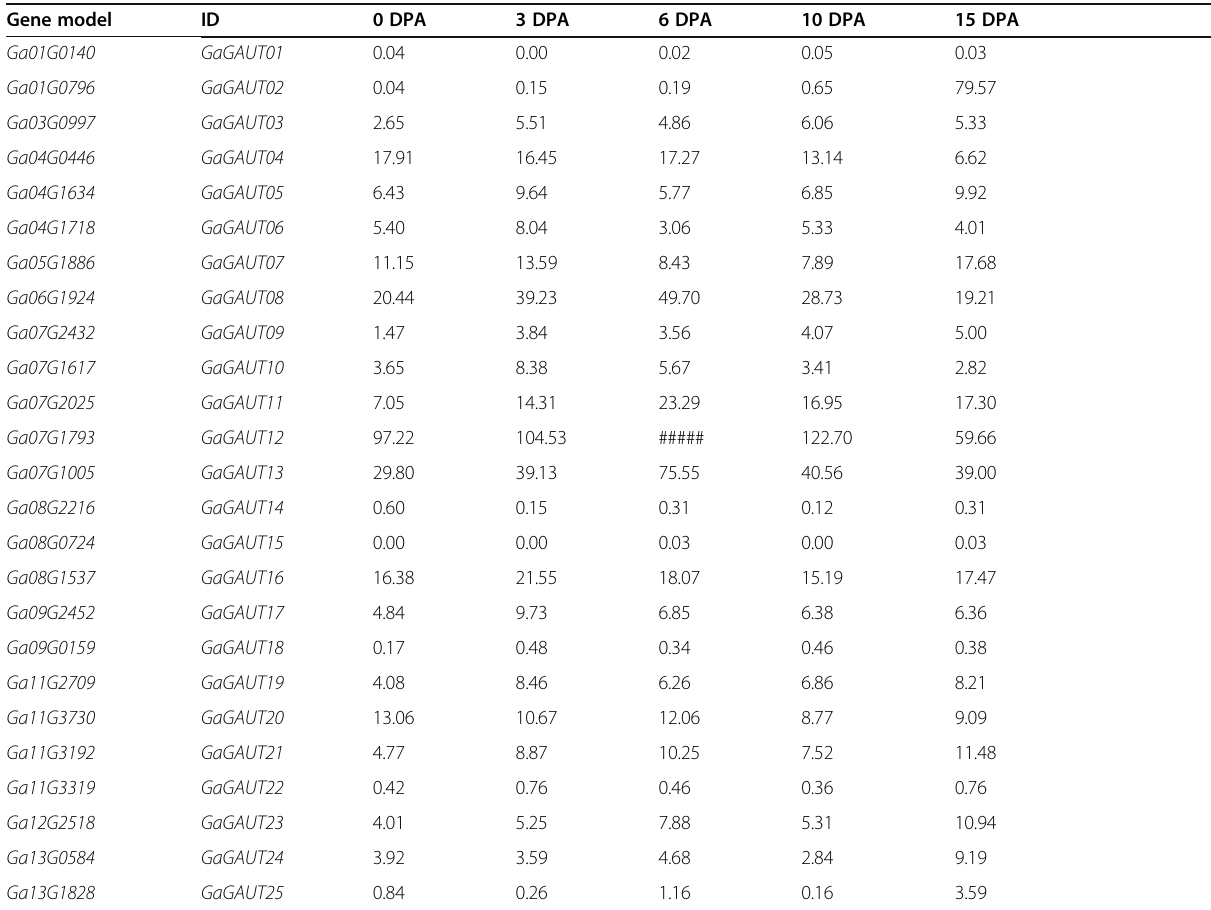
Table 2 The FPKM value of GAUT genes in G. arboreum Gene